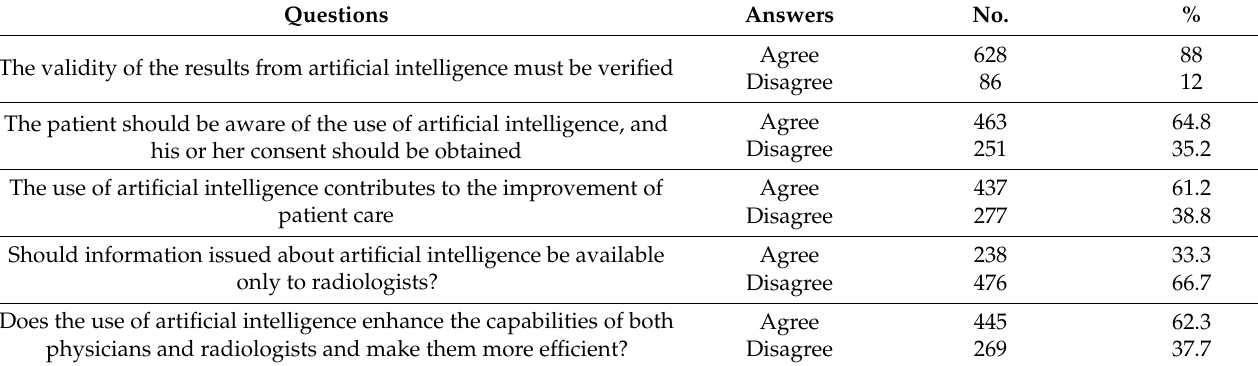
Table 4. Responsibilities